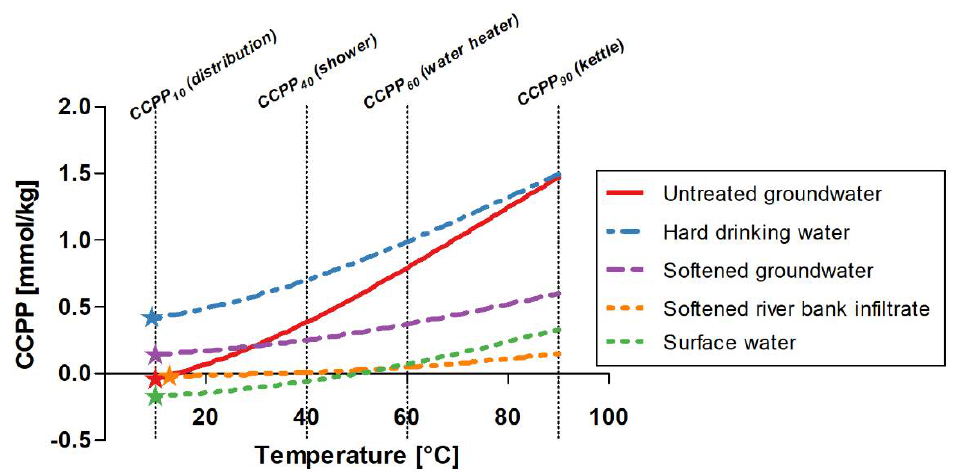
Figure 1. CCPP as function of increasing temperature. Stars represent CCPP at the sample temperature. Untreated groundwater: Frederiksberg. Hard drinking water: Thorsbro. Softened drinking water: Brøndbyvester. Softened riverbank infiltration: Lekkerkerk. Surface water: Ülemiste. The very hard water types (Frederiksberg and Thorsbro) increased the most (1.08–